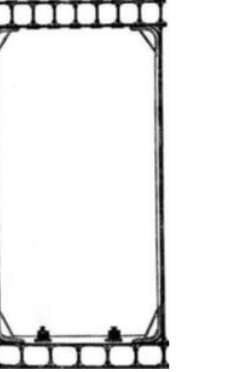
Figure 19. Britannia Bridge. Cross section and general view of the structure, designed by Stephen- son, Wales. 1852. Source: “ The Britannia Tube Railway Bridge ” . Illustrated London News 13 January 1849.